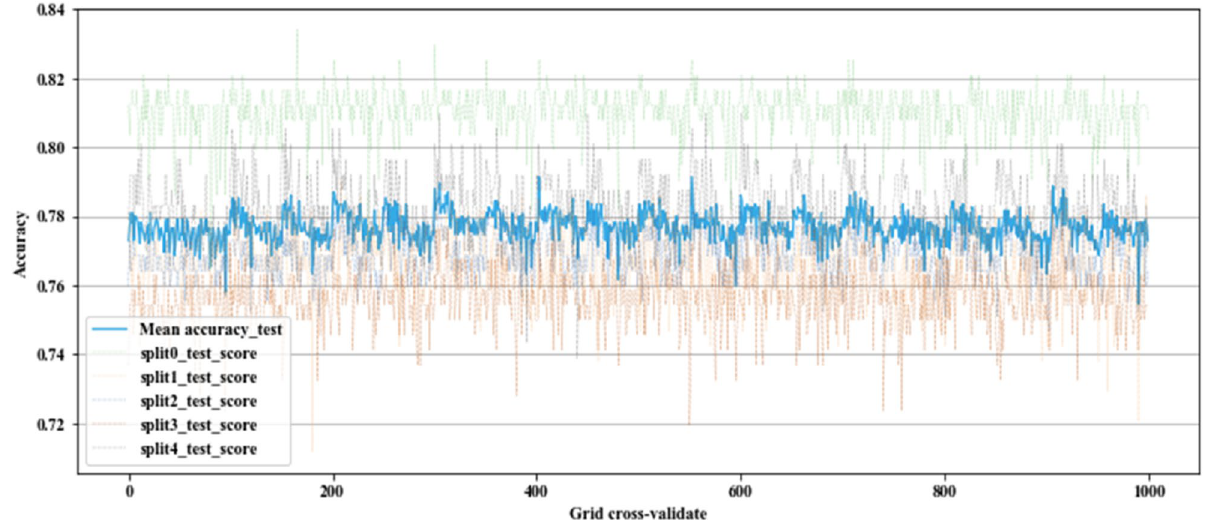
Figure 1. Accuracy score on different combination of hyper-parameters [plotted by Python Matplotlib v. 3.3.4 https:// matpl otlib. org].